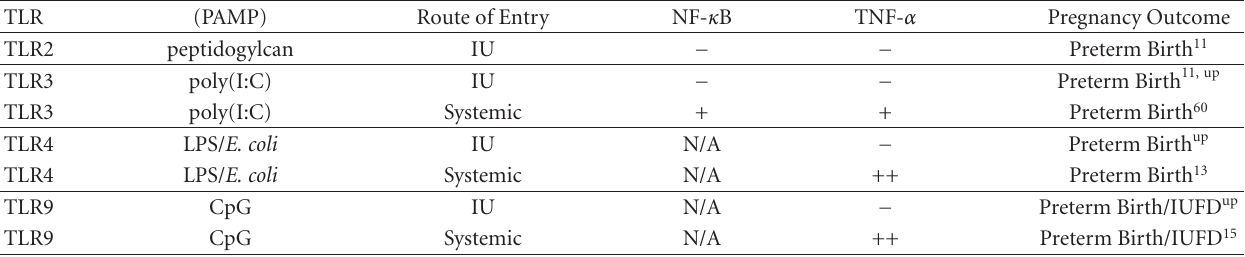
Table 1: Routes of pathogenic entry coupled to specific TLR activations lead to preterm birth via NF- κ B-TNF- α -dependent and independent